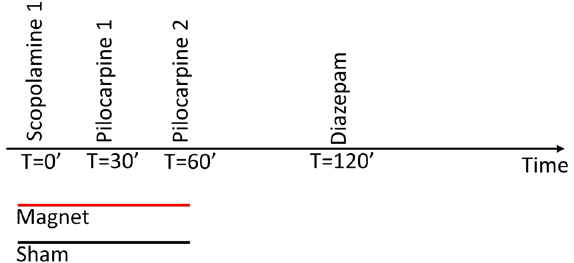
Figure 1. Schematic diagram showing the time schedule for the magnet and drug administration protocol during the recording session: T = 0 scopolamine (1 mg/kg), T = 30 pilocarpine (20 mg/kg), T = 60 pilocarpine (20 mg/kg), T = 120 Diazepam (1.25 mg/kg), all drugs were i.p. administered. Magnet or Sham were applied for 1 h, starting at T =